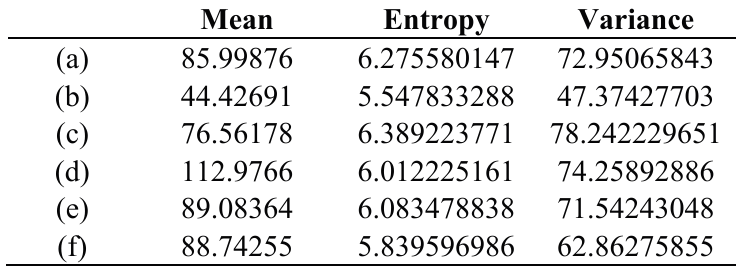
Figure 11. The magnified version of the red box shown in Figure 10a: ( a ) The reference image with 18 dB gain; ( b ) underexposed image with 12 dB gain; ( c ) enhanced image of (b) using ordinary two-pixel digital pixel binning, ( d ) enhanced image of (b) using Kim’s algorithm; ( e ) enhanced image of (b) using Jiang’s algorithm; and ( f ) enhanced image of (b) using the adaptive four-pixel digital pixel binning algorithm. Table 3. Mean, entropy, and variance values of four images in Figure